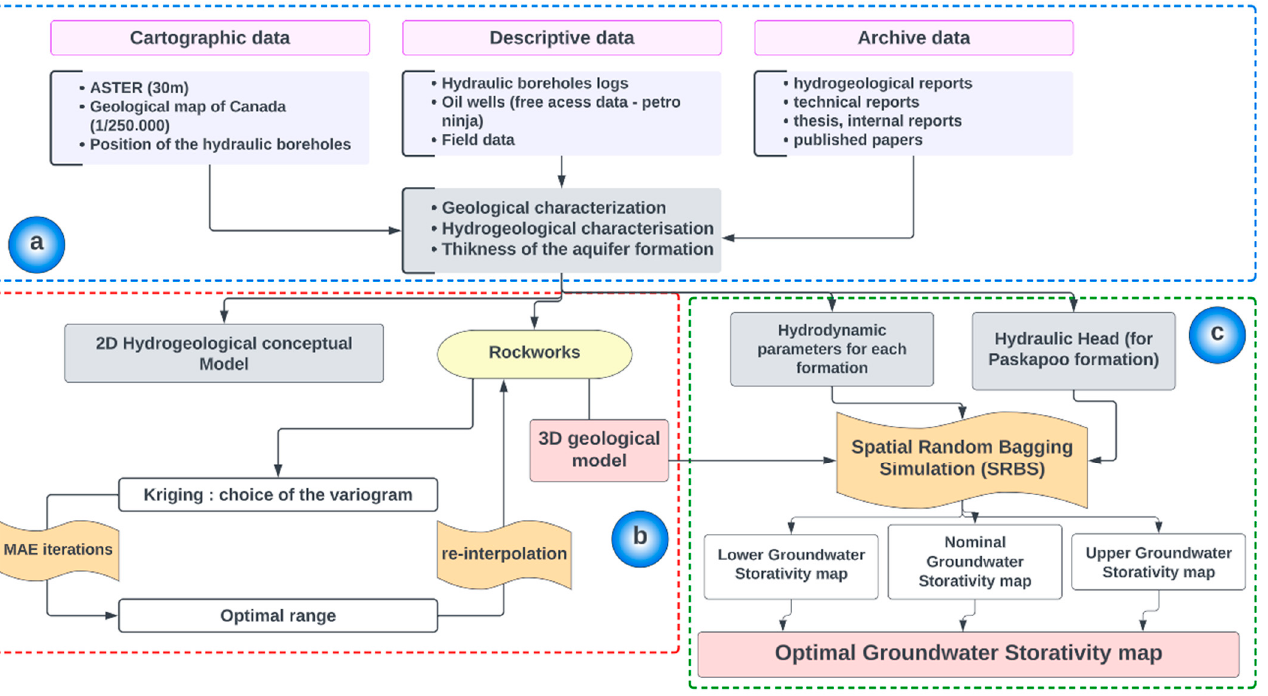
Figure 3. Methodological scheme for the construction and implementation of the hydrogeological conceptual model of the SRB: ( a ) database design and preparation, ( b ) 3D geological modeling using a geostatistical study, and ( c ) the uncertainty assessment using the SRBS and groundwater storativity estimation.